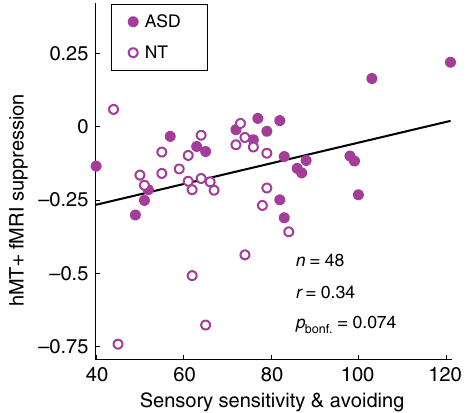
Fig. 3 Relationship with sensory dysfunction. Weaker fMRI suppression in foveal hMT + was associated with higher combined scores for sensory sensitivity and avoiding from the Sensory Pro fi le, across both ASD and NT participants. Black line indicates linear trend. Correlation is Pearson ’ s r